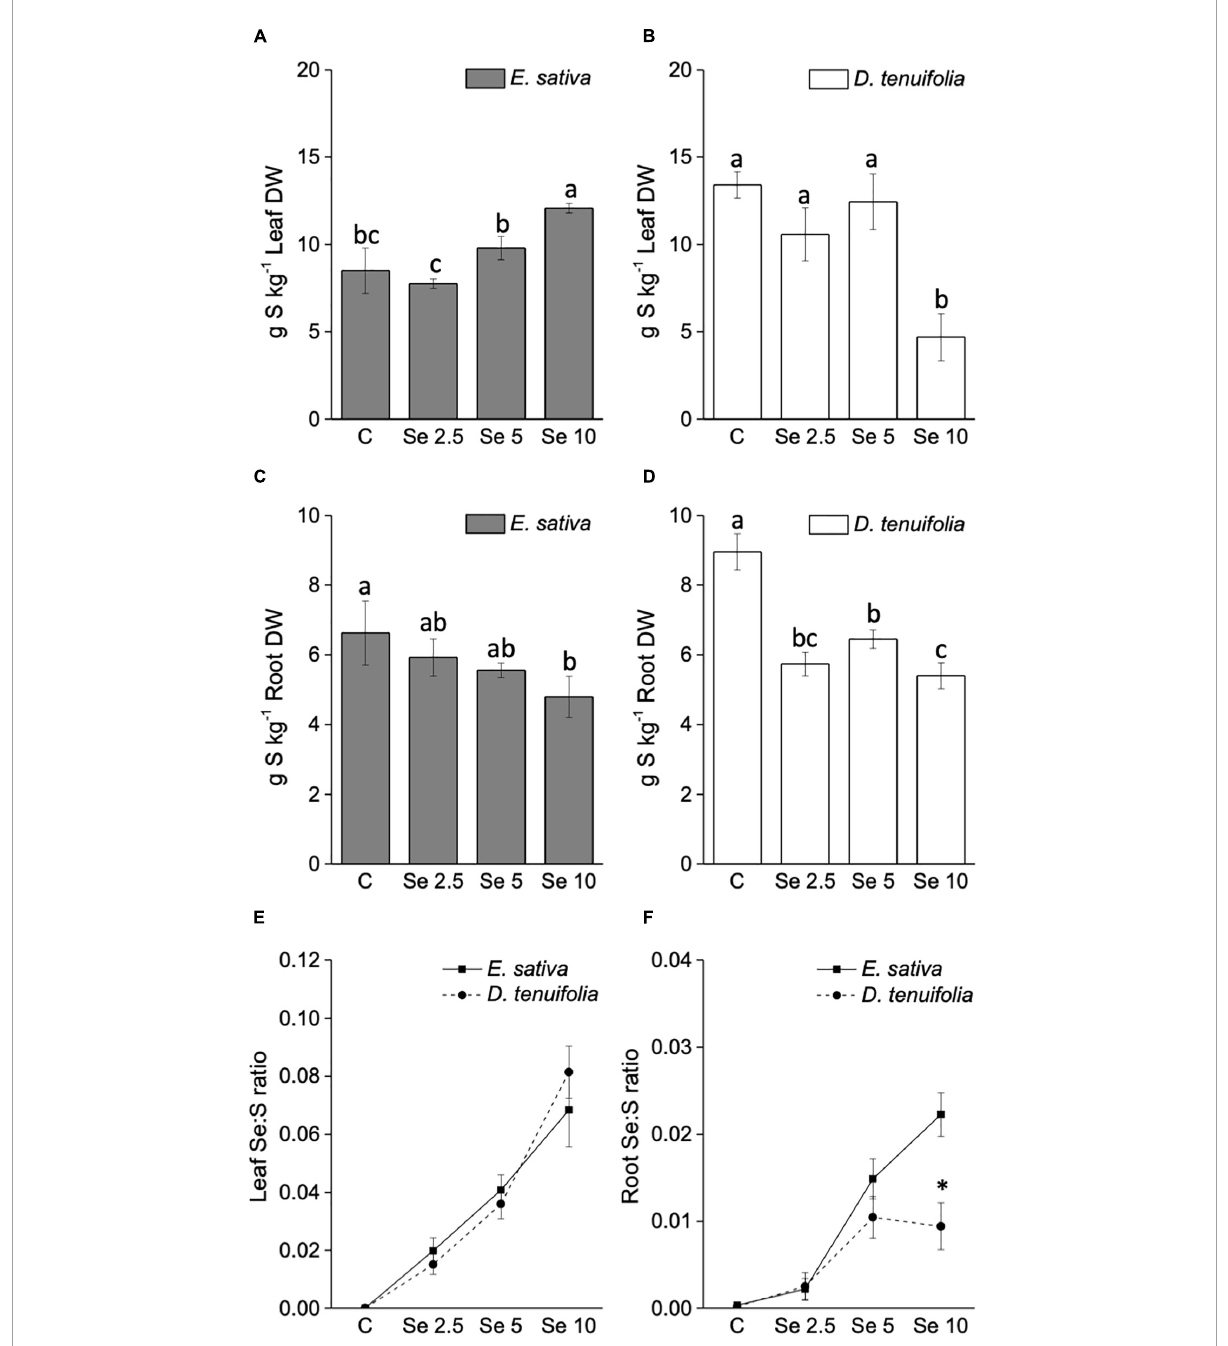
FIGURE3 Sulfur concentration in leaves (A,B) and roots (C,D) of E. sativa and D. tenuifolia plants grown in soil and subjected to foliar fertilization with selenate dosages ranging from 0 to 10 mg per plant. Se:S ratio of leaves (E) and roots (F) of the two rocket species. Data shown are the mean ± SD of three replicates. Different letters above bars indicate significant differences between the means ( p < 0.05). In the line graph, the asterisks indicate significant differences in the root Se:S ratio between the two rocket